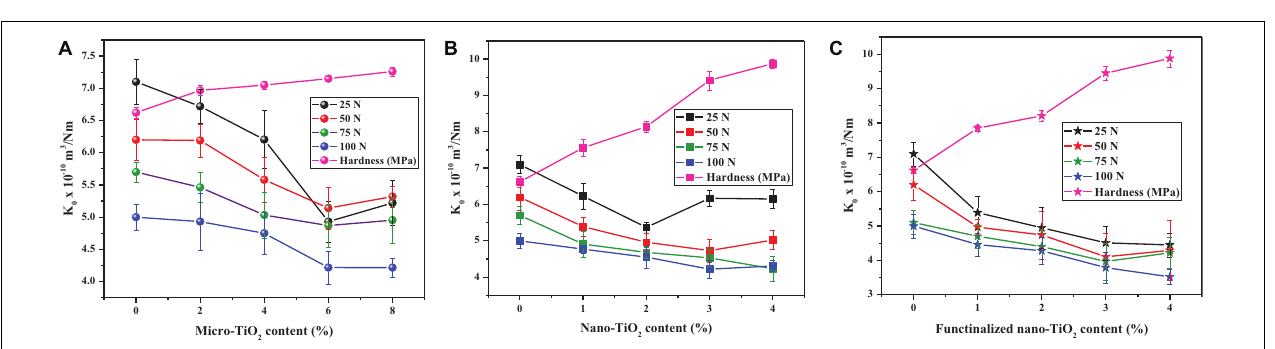
FIGURE 8 | Effect of contents of Titania particles on the abrasive wear of UHMWPE as a function of load for (A) microcomposites (MCs), (B) nanocomposites (NCs), and (C) functionalized nanocomposites